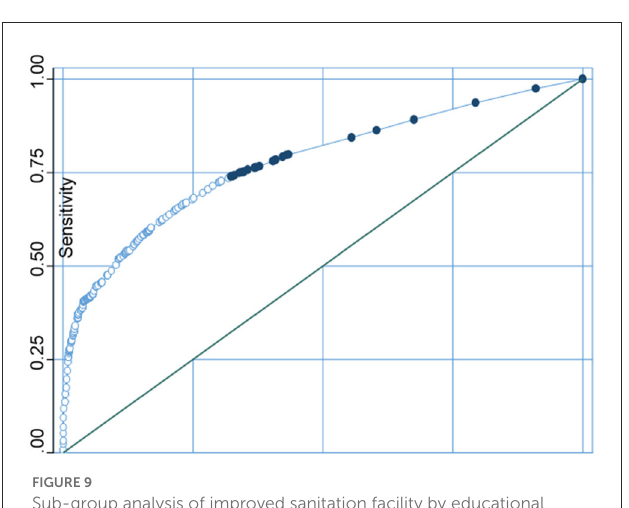
FIGURE10 Sensitivity analysis curve of water